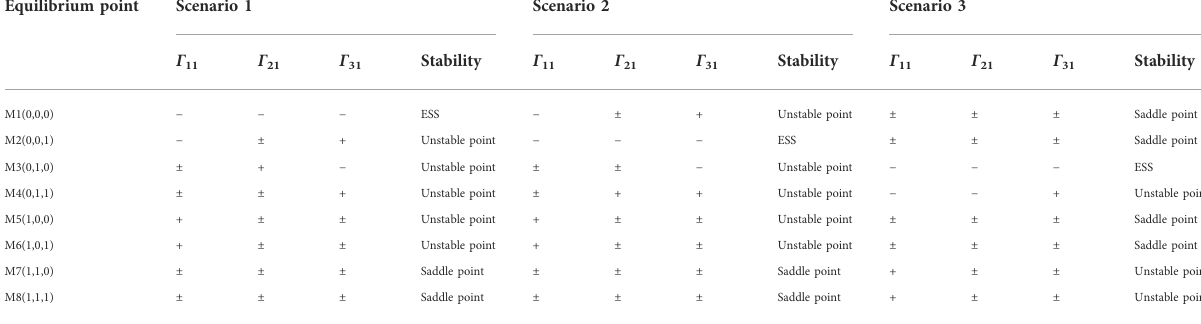
TABLE 4 Stability analysis of equilibrium points for scenarios 1 – 3. Equilibrium point Scenario 1 Scenario 2